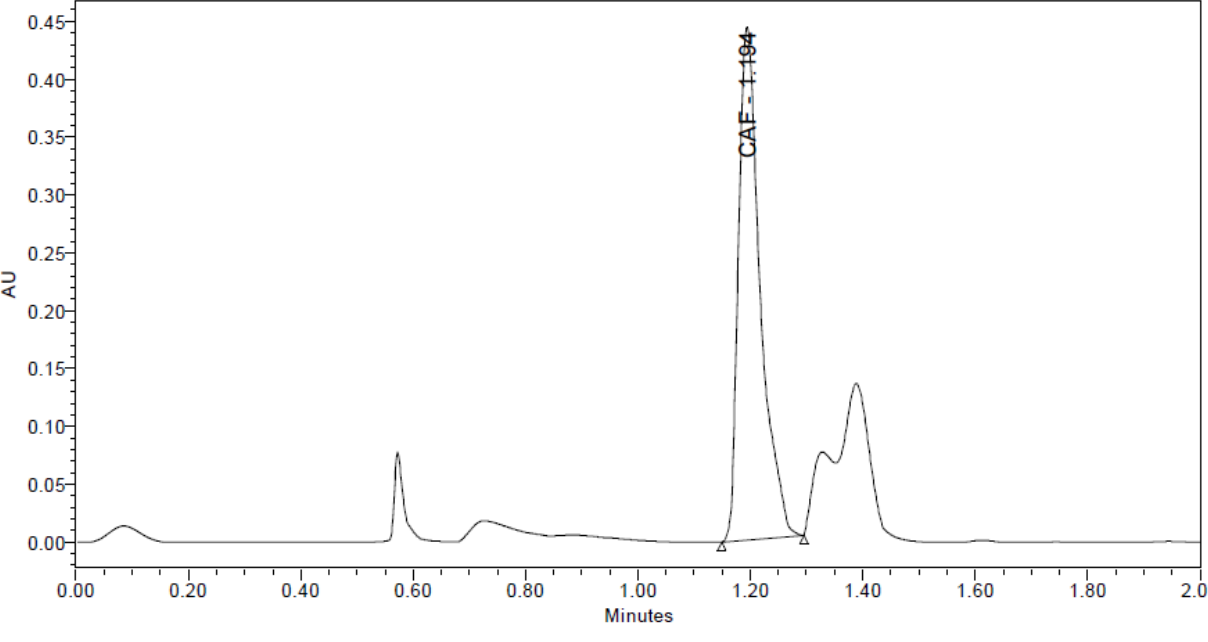
Figure 10. Chromatogram of PCM and CAF for wet heat degradation. 2.5. Comparison with Reported Analytical Methods To study performance, few chromatographic characteristics of the proposed UPLC method were compared with those of existing methods; the comparison is presented in Table 7. Several chromatographic characteristics, including run time, linearity range, and retention time, of the proposed procedure were in contrast with those of some published studies. However, the linearity range (PCM 40–400 ng/mL and CAF 7–70 ng/mL) of the proposed procedure is lower than that of the reported methods. The linearity ranges of the UPLC-MS method presented in the literature have been reported to be 0.05–250 for PCM and 0.01–5 µg/mL for CAF, which were also inferior to those of the UPLC method [24]. The run time of the proposed procedure is considerably short and, thus, highly sat- isfactory for the separation of PCM and CAF. For PCM and CAF, the retention times of